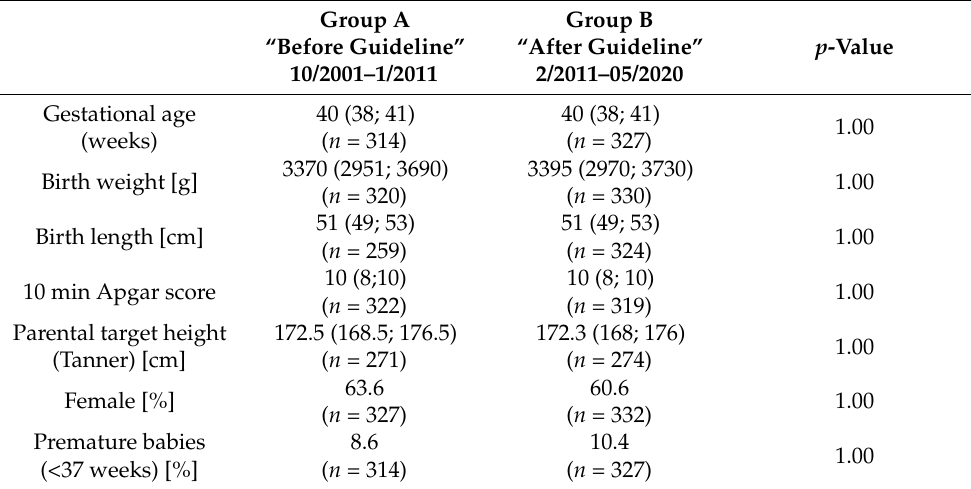
Table 2. Demographic characteristics of CH patients, compared before and after guideline appearance (groups A and